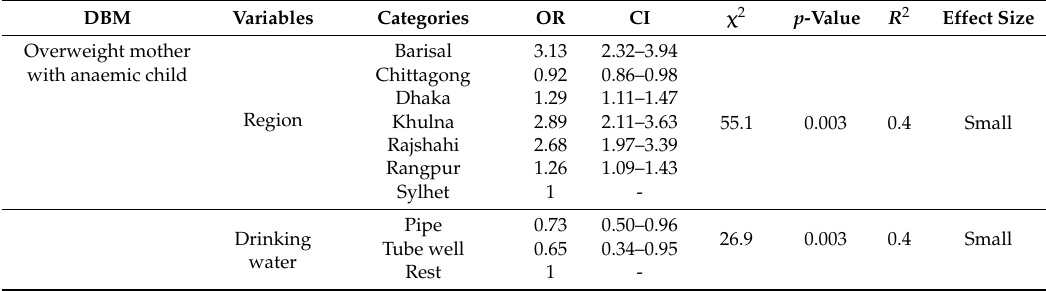
Table 8. Sequential multinomial logistic regression analysis of overweight mother and anaemic child pairs by socio-demographic